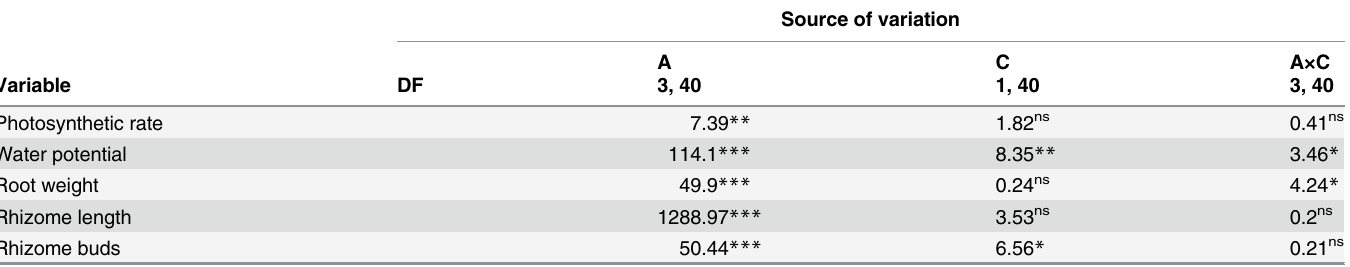
Table 2. Analysis of variance for the effects of alkalinity stress (A) and rhizome connection (C) on the photosynthetic rate, water potential, root weight, rhizome length and rhizome buds of subsequent ramets.